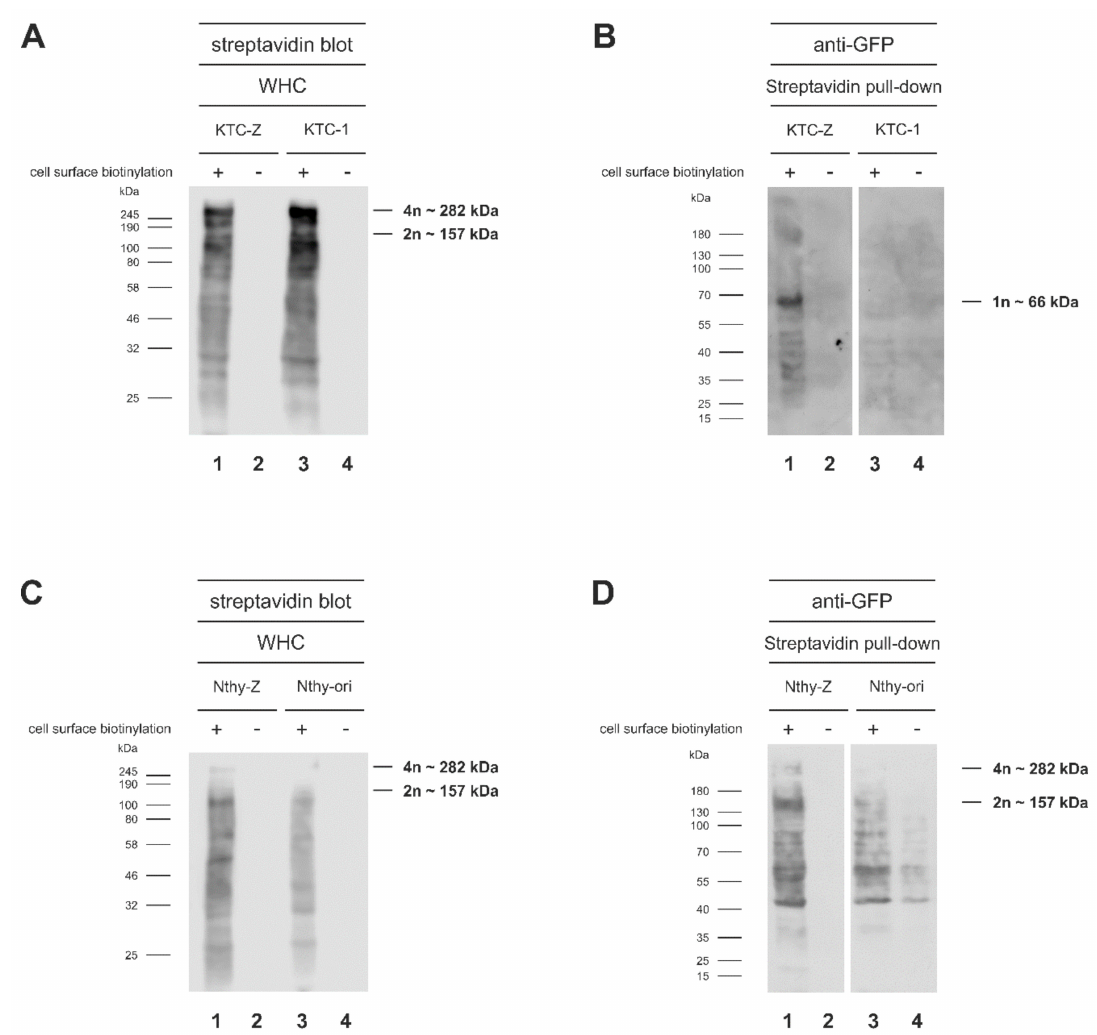
Figure 3. Chimeric mTaar1-EGFP reaches the surface of KTC-Z and Nthy-Z cells. KTC-Z and Nthy-Z cells were subjected to cell surface biotinylation (+) or not ( − ), cell lysates were separated on 12.5% SDS-PAGE, and blots were labeled with streptavidin conjugated to HRP ( A , C ). In addition, streptavidin-coated beads were used to enrich cell surface-biotinylated proteins prior to separation by SDS-PAGE and immunoblotting with anti-GFP antibodies ( B , D ). Streptavidin-positive bands equivalent to the GFP-positive bands at 282 kDa and 157 kDa can be detected on the streptavidin blots, particularly in Nthy-Z cell lysates ( C ). A stronger streptavidin signal is seen in KTC-Z cells ( A , lane 1), suggesting that more mTaar1-EGFP may be reaching the cell surface in KTC-Z than in Nthy-Z cells. To enrich for cell surface-biotinylated proteins, streptavidin pull-down was used with transduced KTC-Z and Nthy-Z cell lysates and their non-transduced controls ( B , D ). Preparations from Nthy-Z and Nthy-ori 3-1 cells were not conclusive ( D ). In KTC-Z preparations, however, the anti-GFP antibodies recognized a band of approx. 65.8 kDa in cell surface biotinylated proteins enriched by streptavidin precipitation ( B , lane 1), indicating cell surface delivery of monomeric